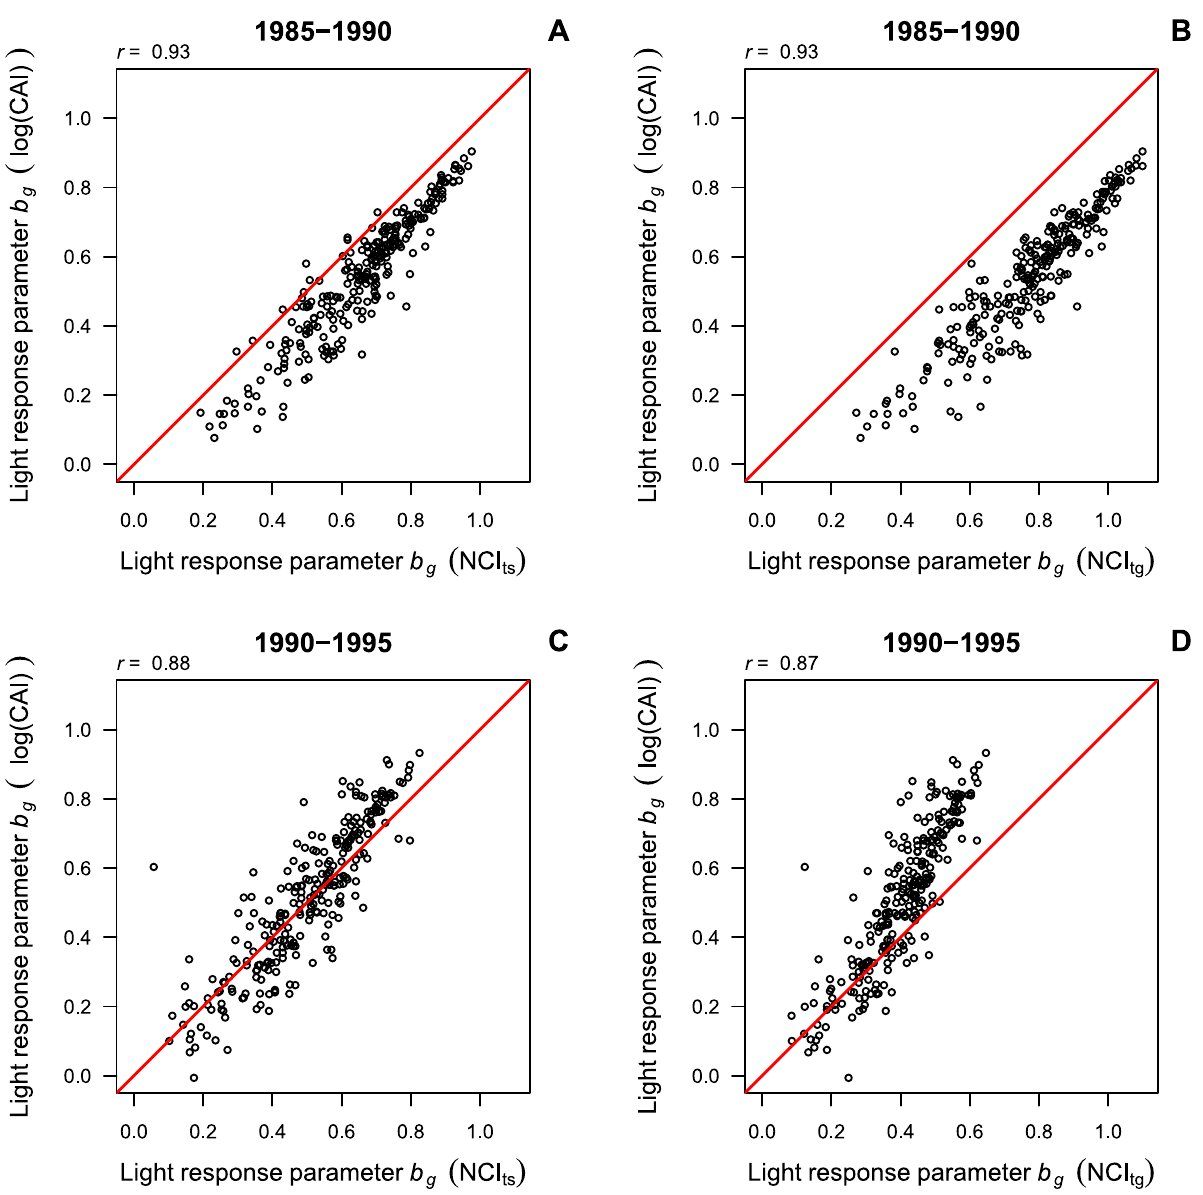
Figure 6. Species-specific light response of growth ( b g ) in models with neighborhood competition index versus canopy index. Panels show posterior means of b g in models with the interval-specific neighborhood competition index (NCI ts , A, C) and the general neighborhood competition index (NCI tg , B, D) compared to b g in models with the canopy index (log(CAI)). The correlation between the coefficients ( r ) and the 1:1 line are indicated.